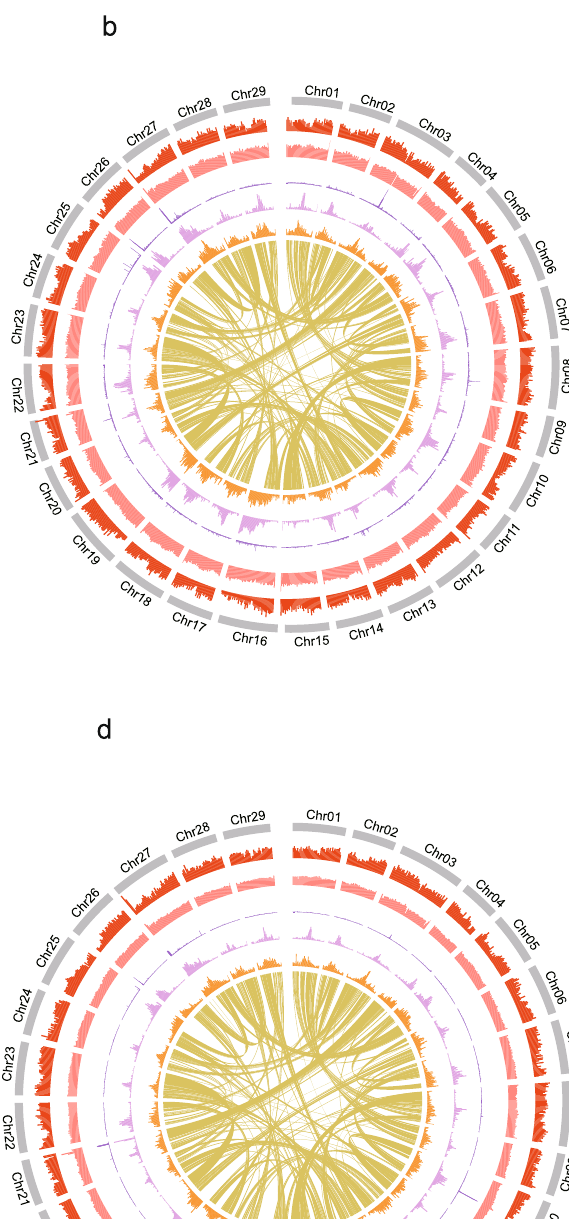
Fig. 1 Hi C map and overview of the genomic features of of A. eriantha . Heatmap showing Hi − The genomic features of MDHAPA ( b ) and MDHAPB ( d ). Tracks from outside to inside are chromosomes number, gene density, GC content, tandem repeat density, LTR/Gypsy density, LTR/Copia density, links between